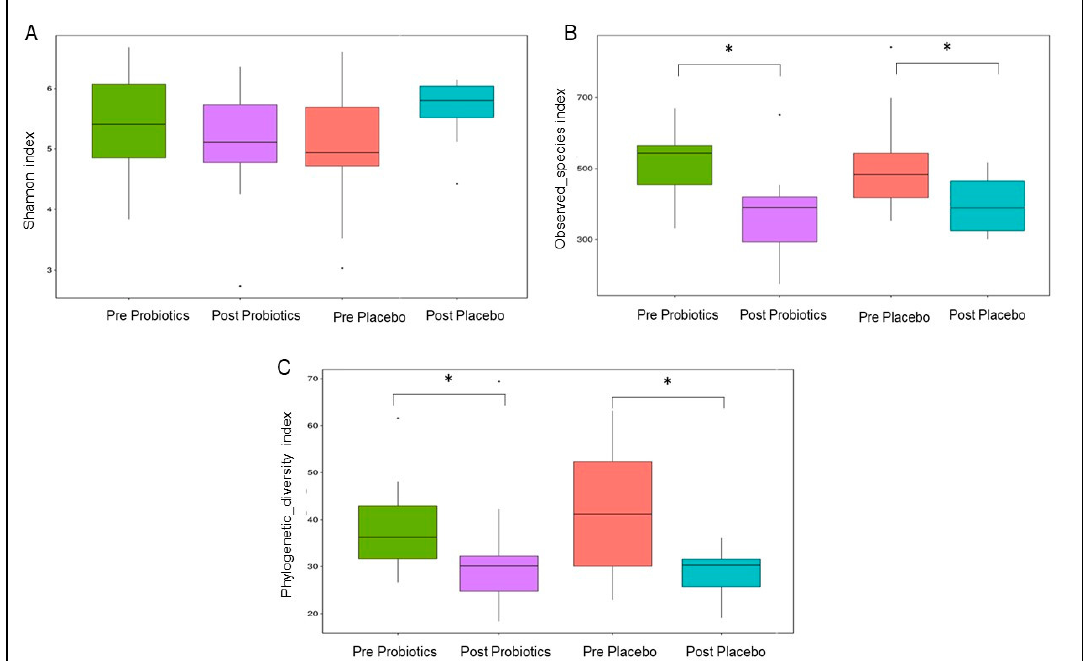
Figure 5. Changes in gut microbial α diversity within the two groups. ( A ) Shannon diversity index represents gut microbial evenness. ( B ) Observed_species index represents gut microbial richness. ( C ) Phylogenetic_diversity index represents gut microbial phylogenetic difference. * p -value < 0.05 was considered as statistically significant.